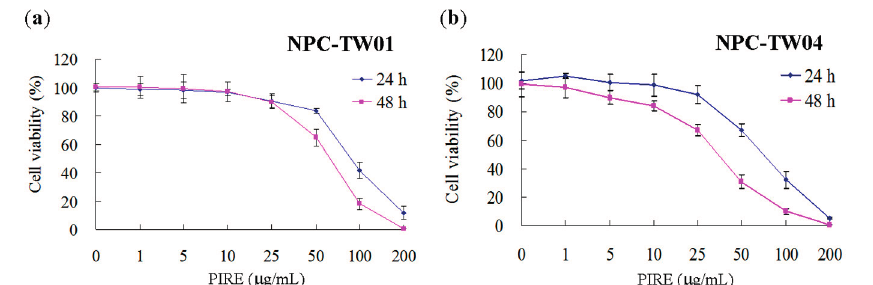
Figure 1. Anti-proliferative activity of PIRE in NPC-TW 01 and NPC-TW 04 cells. ( a ) NPC-TW 01 and ( b ) NPC-TW 04 cells were treated with 0–200  g·mL − 1 PIRE, and viabilities were determined using WST-1 assay after 24 h and 48 h. Percent cell viability of each experimental group was calculated, with 100% representing cells treated with 0.1% DMSO alone (control). The results are the means ± SD from three experiments.